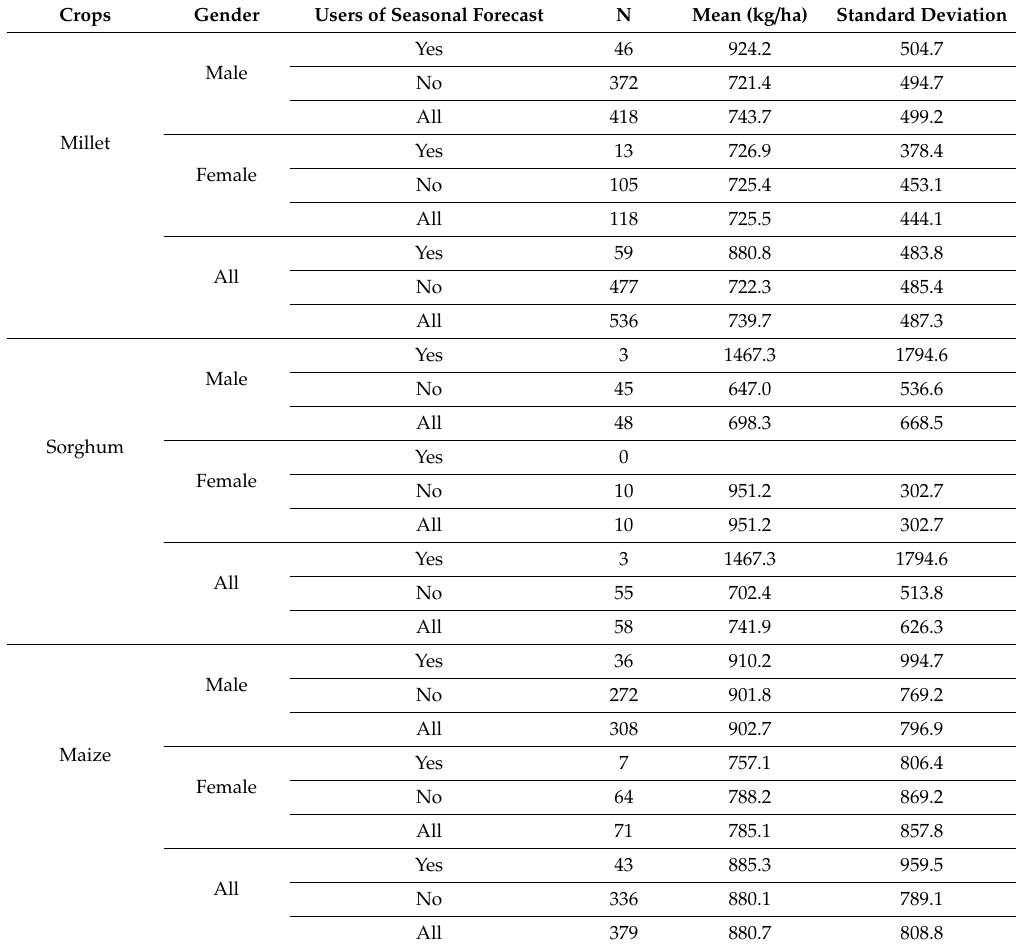
Table 6. Yield comparison by gender and